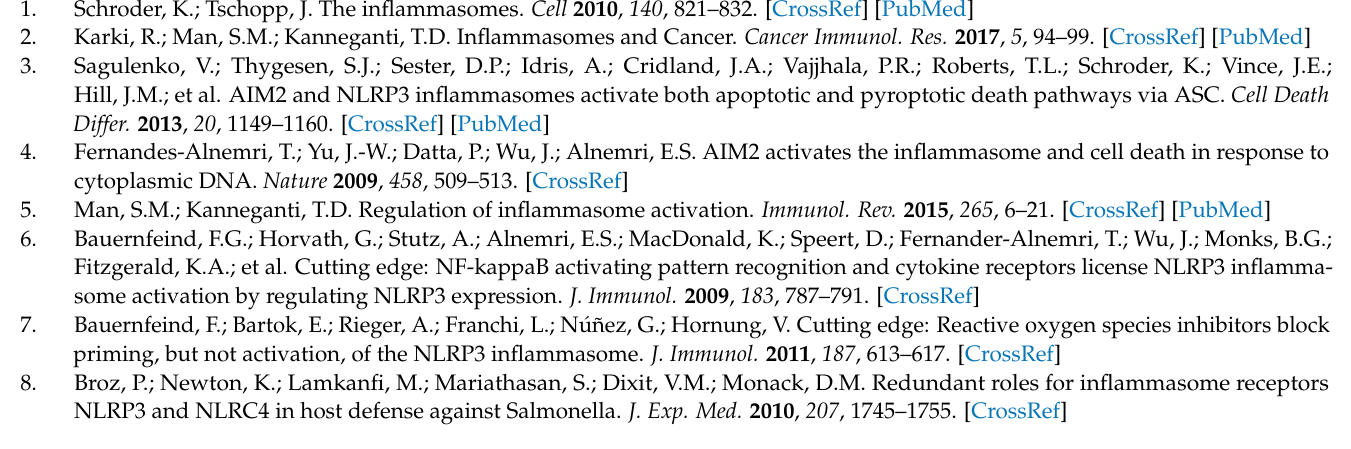
solvent. Figure S3: (a) Toxicity evaluation of MNP, QD and MNP@QD in colony forming assays. Figure S4: (a) Toxicity evaluation of MNP@QD + NaCl. (b–h) Triggering study of IL-6, TNF-a and IL-12p70 cytokines secretion before and after LPS 24 h incubation. (i) Triggering study of IL-1b